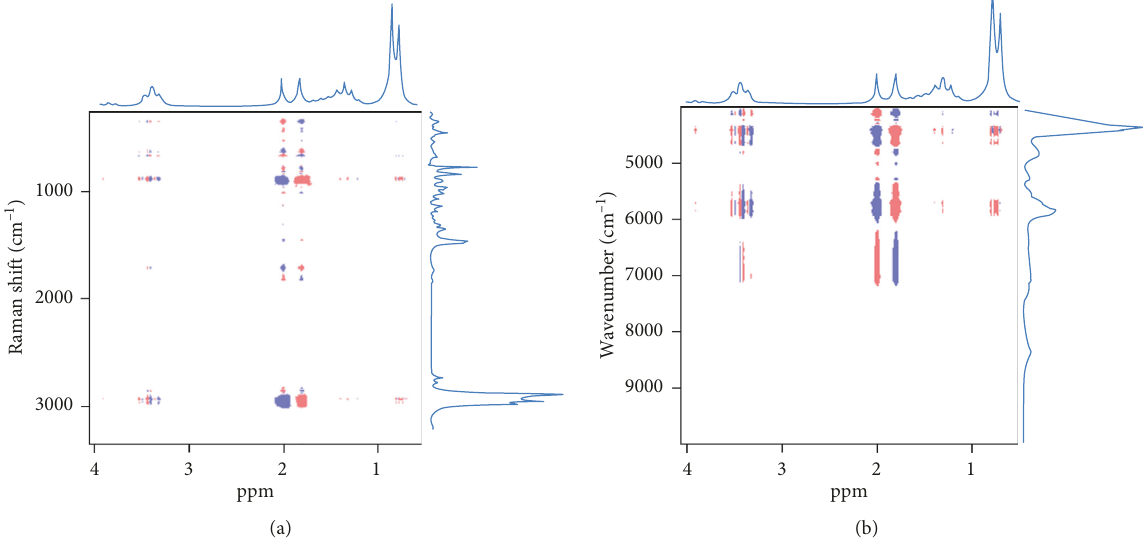
Figure 3: 2D 1 H NMR-Raman heterocorrelation spectra (a) of isoamyl acetate from immobilized lipase catalysis using in-line Raman spectroscopy ( λ � 785nm) and on-line 1D 1 H NMR. 2D 1 H NMR-NIR heterocorrelation map